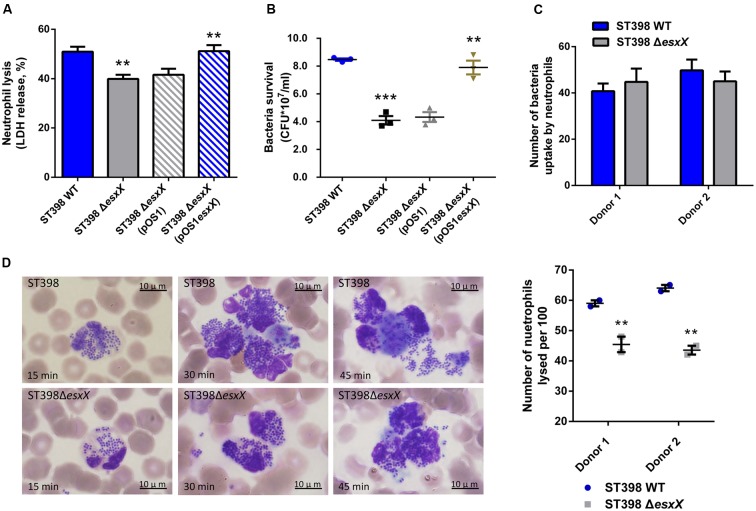
EsxX promotes neutrophil lysis and contributes to evasion of elimination by human neutrophils.
(A) Neutrophil lysis. Human neutrophils were isolated from heparinized venous blood of healthy individuals. Bacteria were grown to the mid-logarithmic phase and incubated with neutrophils at a 10:1 ratio. Neutrophil lysis was determined by measuring the release of LDH. (B) Bacterial survival. Bacterial survival was measured by incubating a mixture of bacteria and neutrophils and plating for CFUs. ∗∗p < 0.01; ∗∗∗p < 0.001 (unpaired t-tests of the deletion mutant versus wild type strain and the complemented mutant versus the deletion mutant harboring a control plasmid). (C,D) Microscopic evaluation of neutrophil phagocytosis. Blood smears were obtained at different time points in the incubation of bacteria with neutrophils. Ingestion of bacteria and neutrophil lysis were analyzed by light microscopy using a modified Wright-Giemsa stain. (C) The numbers of intracellular S. aureus. Twenty neutrophils per group were used to examine the number of intracellular S. aureus after 30 min of infection. (P > 0.05; D) Neutrophil lysis after phagocytosis. The number of lysed neutrophils among 100 neutrophils that had ingested bacteria is shown on the right for two different donors. ∗∗p < 0.01 (unpaired t-tests).